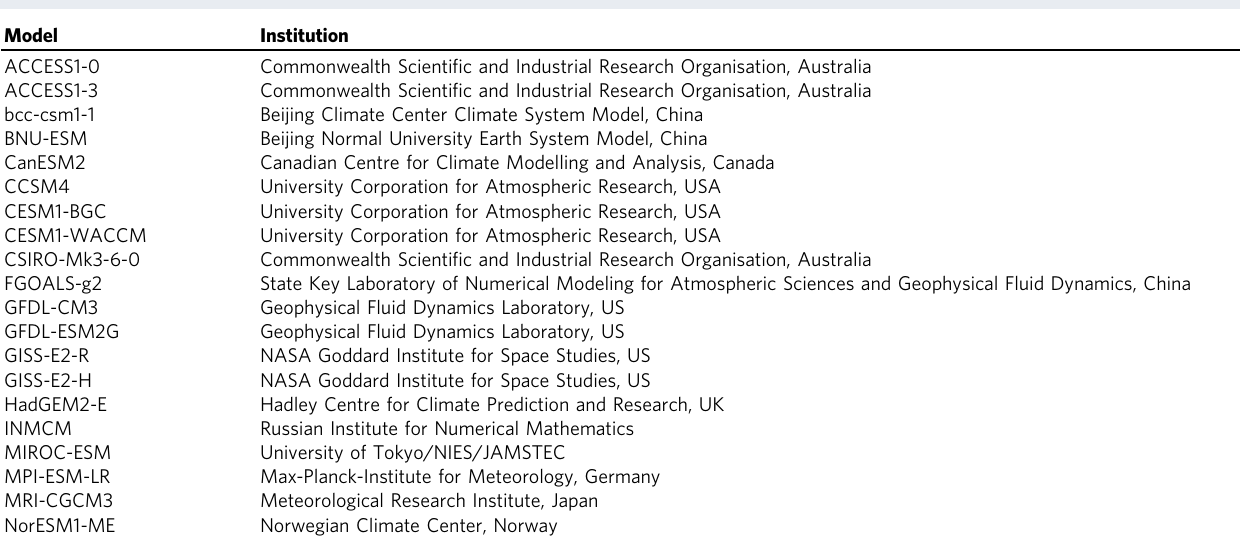
Table 3 List of CMIP5 climate models used in this study.